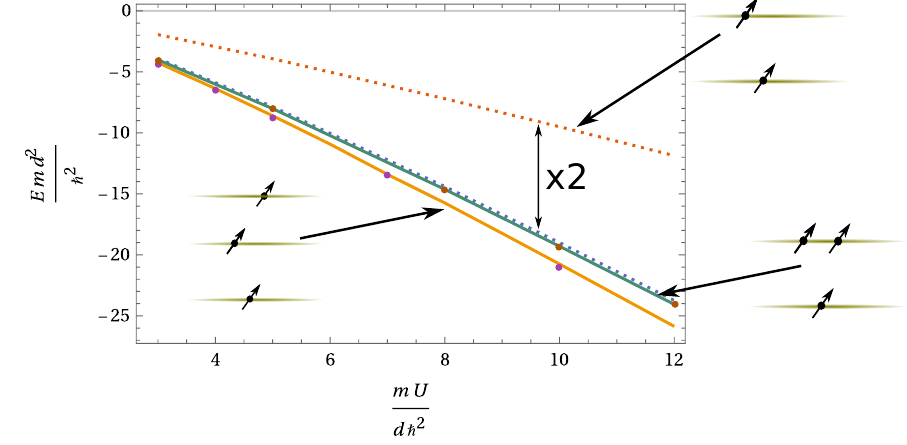
Figure 3. Comparison between the harmonic oscillator (HO) model and the stochastic variational method (SVM) in obtaining energies for few-body dipolar clusters. The solid curves represent the results of the HO model: the upper curve is for the 12 system, the lower is for the 111 system. The dots are the corresponding SVM results. The 111 system is slightly more bound than 12 system due to an additional attraction between the outer layers. For comparison, we also plot the energy of the 11 system (see the upper dotted curve) whose energy, by construction, is the same in the HO and SVM calculations. The lower dotted curve presents two times the energy of the 11 system. Table 1. Comparison between the harmonic oscillator (HO) model and the stochastic variational method (SVM) in obtaining energies for few-body dipolar clusters. The different clusters are three and four particle chains (labeled 111 and 1111, respectively), and a system with two particles in one layer and a single particle in the adjacent layer (labeled 12). The units of energy are ¯ h 2 / ( md 2 ) , and the units of U are ¯ h 2 d / m